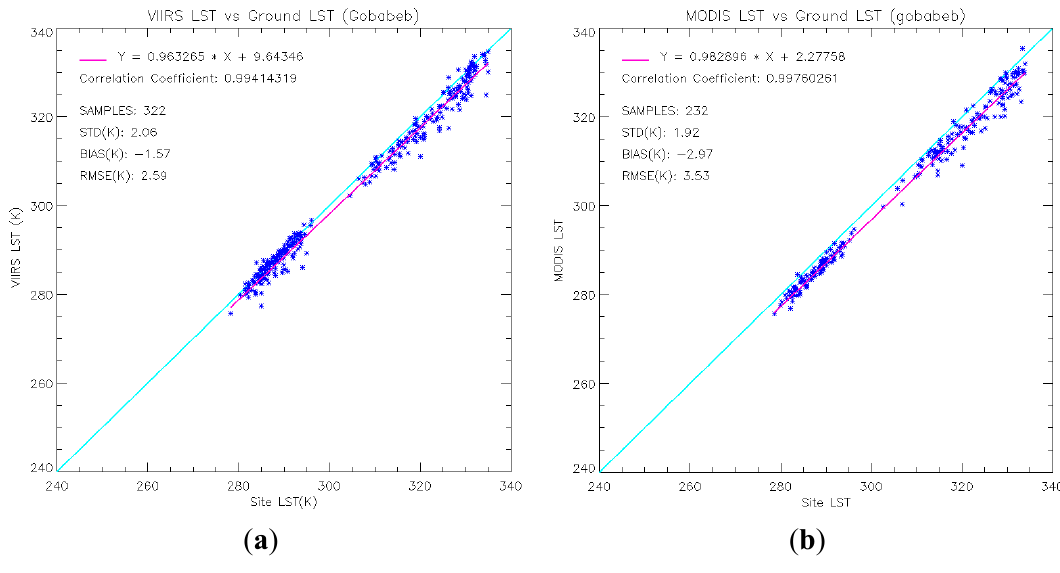
Figure 4. Validation result against the data in Gobabeb, Namibia in 2012: VIIRS LST ( a ) and MODIS LST V5 ( b